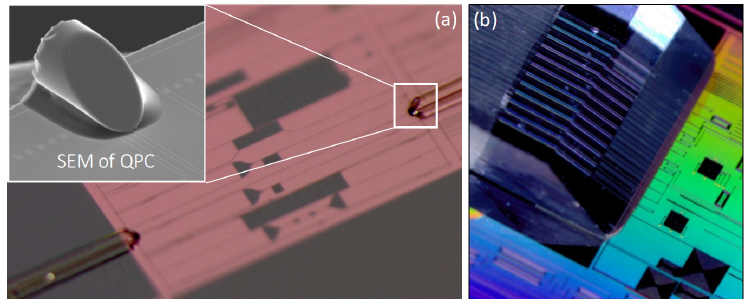
Figure 5. Quasi ‐ planar Coupling (QPC) geometry to allow for the ‘horizontal’ Fiber ‐ to ‐ PIC grating ‐ coupling; ( a ) Single ‐ channel in/out QPC fiber ‐ coupling to a Si ‐ PIC, with an inset showing a schematic of the polished fiber facet; ( b ) QPC fiber ‐ coupling using a multi ‐ channel fiber ‐ array. Grating couplers offer significantly more relaxed alignment tolerance than an edge ‐ coupler,